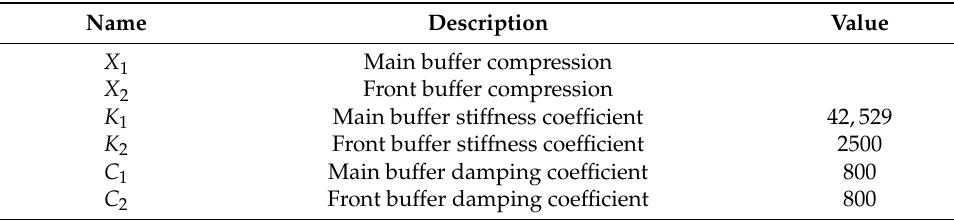
Table 2. Parameters of the buffer.